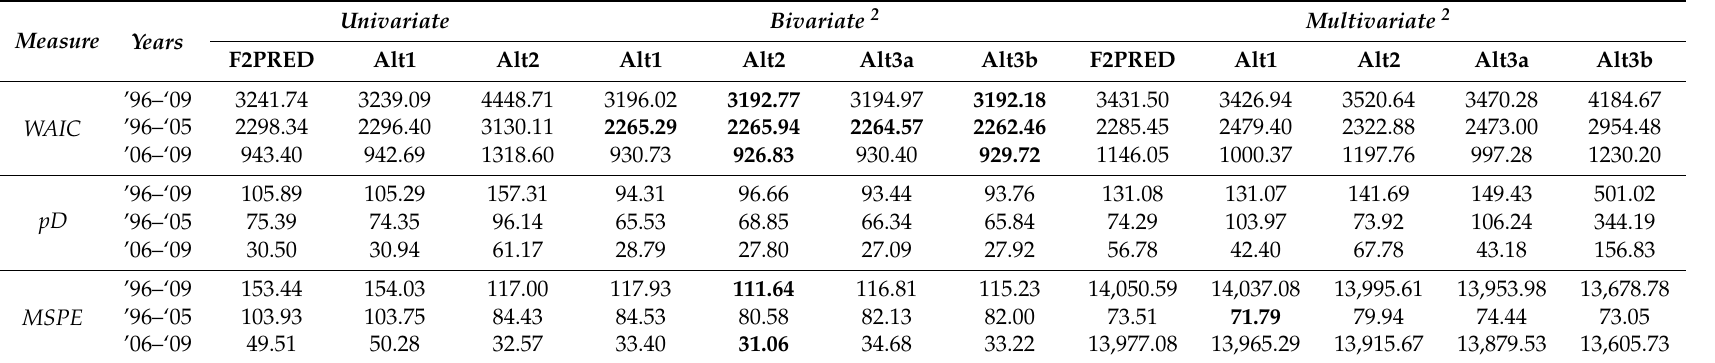
Table 3. Goodness of fit results for oral cavity and pharynx cancer.